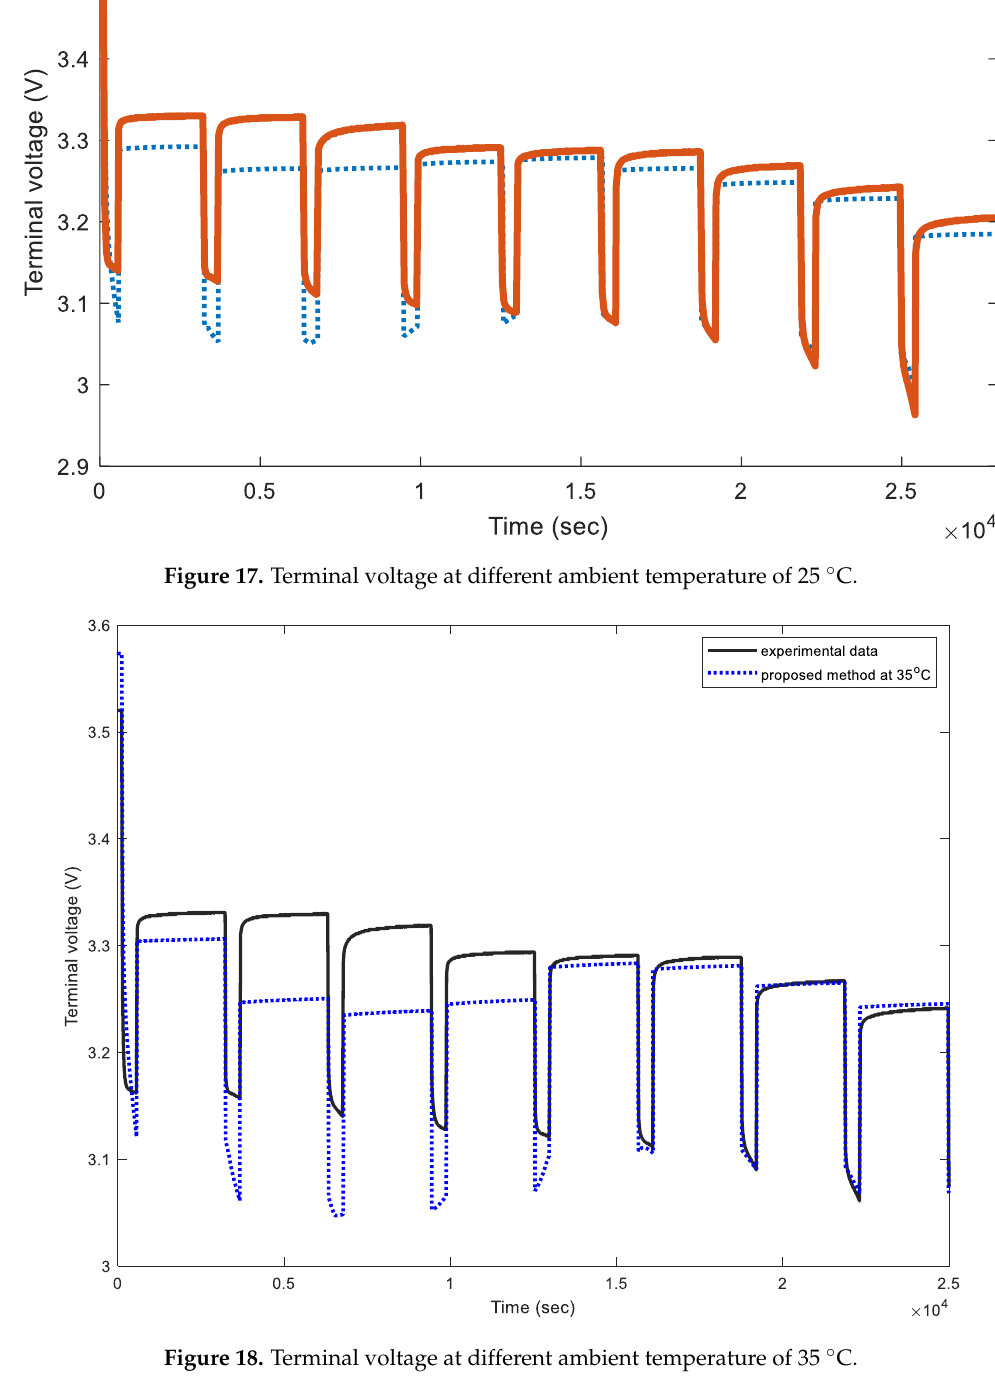
Figure 18. Terminal voltage at different ambient temperature of 35 °C.